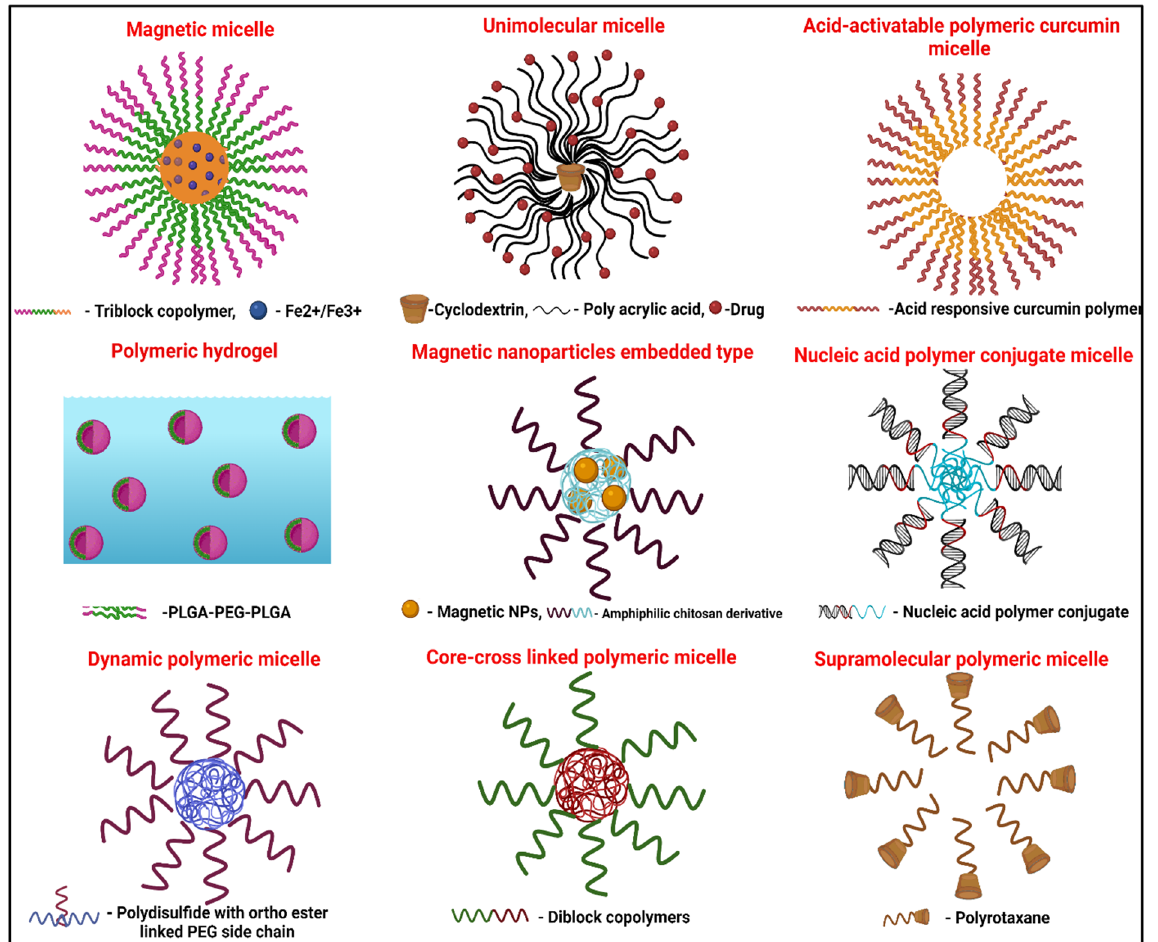
Figure 11. Diagrammatic representation of special types of PMs.